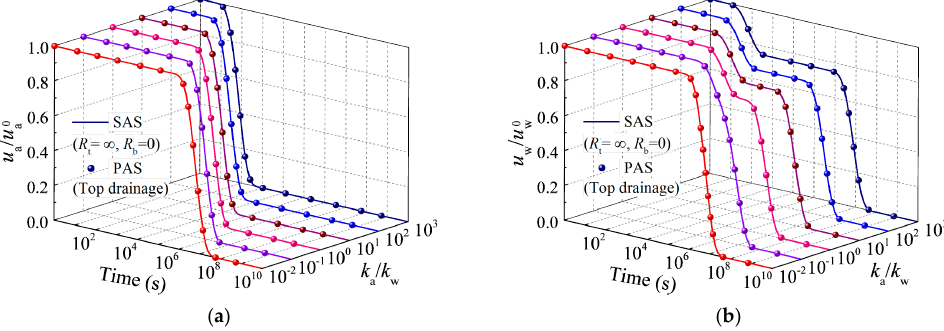
Figure 3. Excess pore-pressures under top drainage boundary calculated from semi-analytical solution (SAS) and previous analytical solution (PAS): ( a ) air phase and ( b ) water phase.